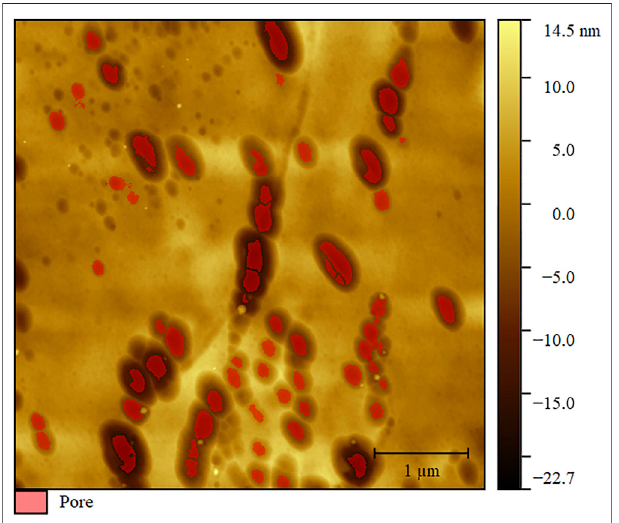
FIGURE 2 | Pores marked by the watershed algorithm.